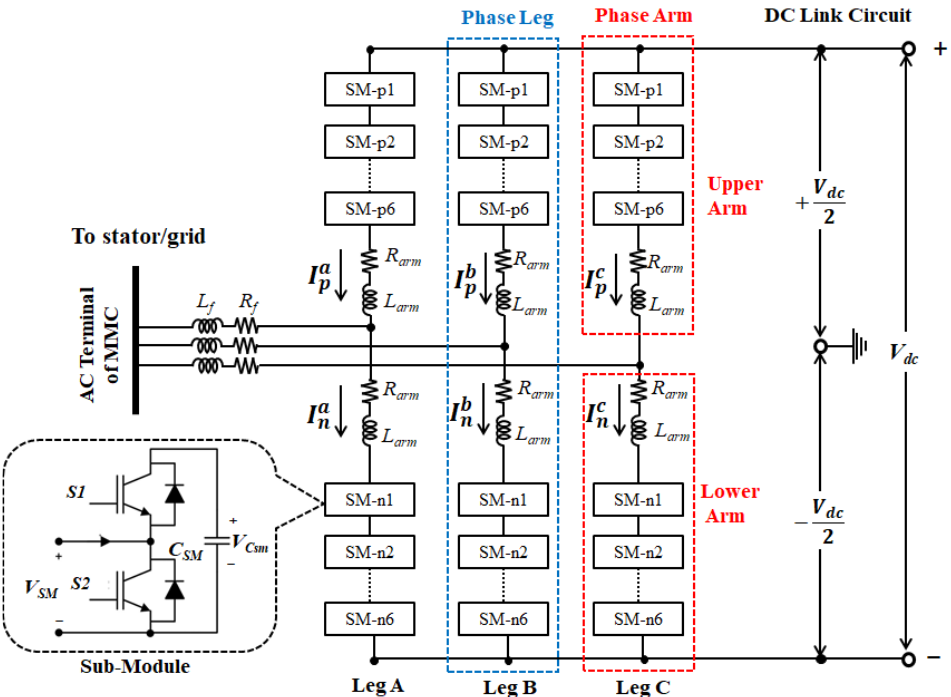
Figure 6. Configuration of MMC.